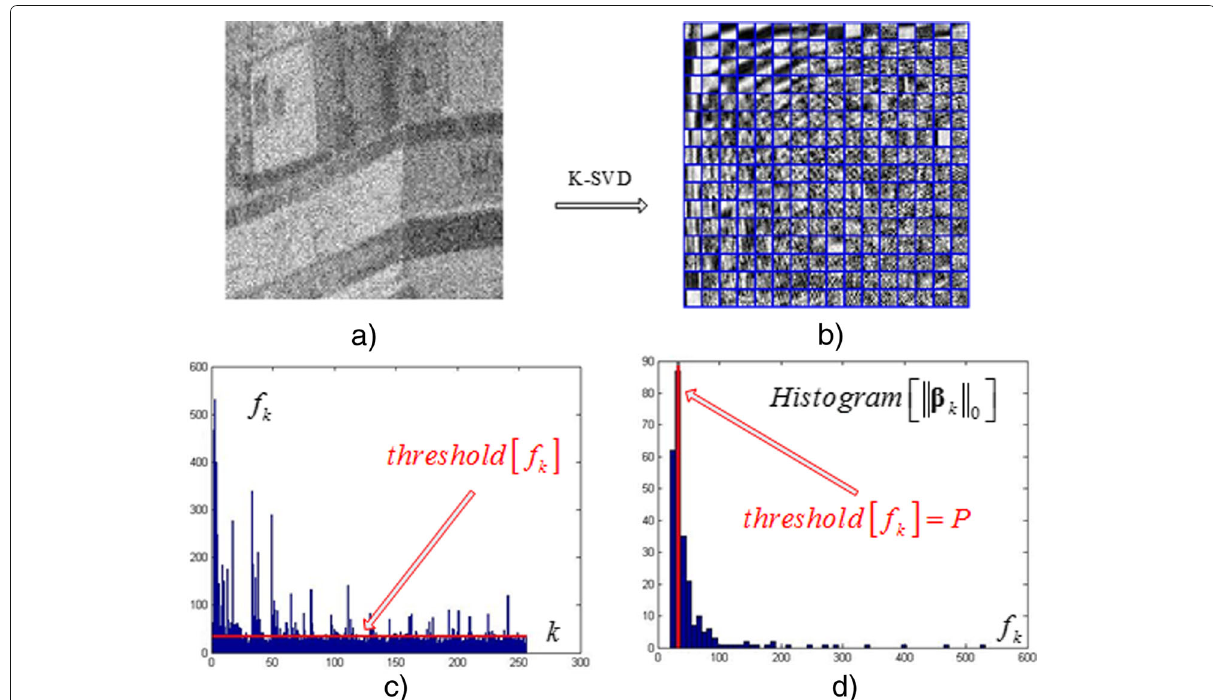
Fig. 2 The threshold P of the frequencies f k s. a Noisy image. b Over-complete dictionary D . c Frequency of d k . d Histogram of d k ’s frequency